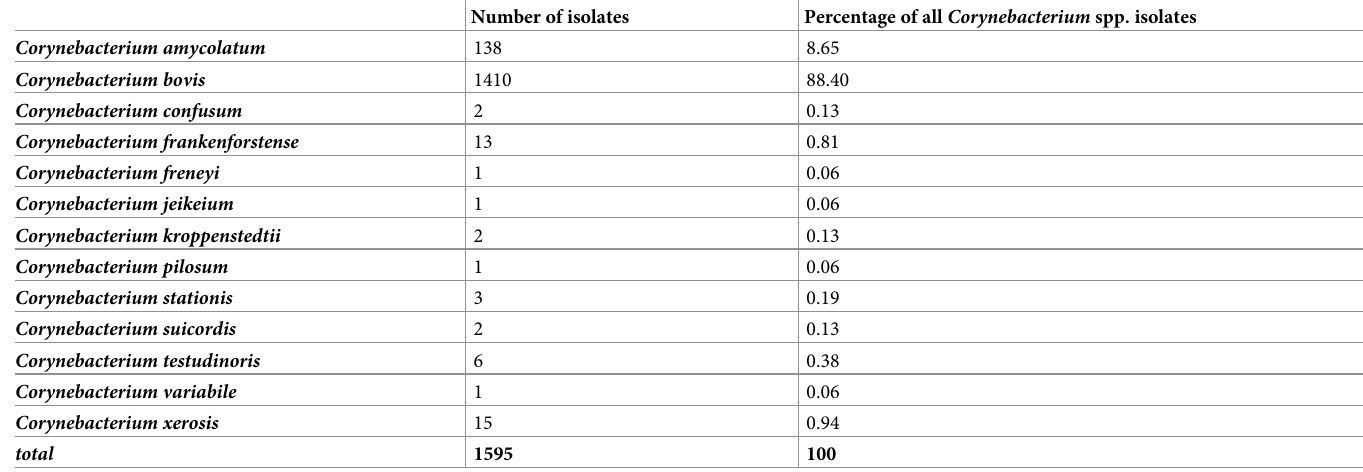
Table 1. Distribution of Corynebacterium spp. isolated from bovine quarter milk samples.